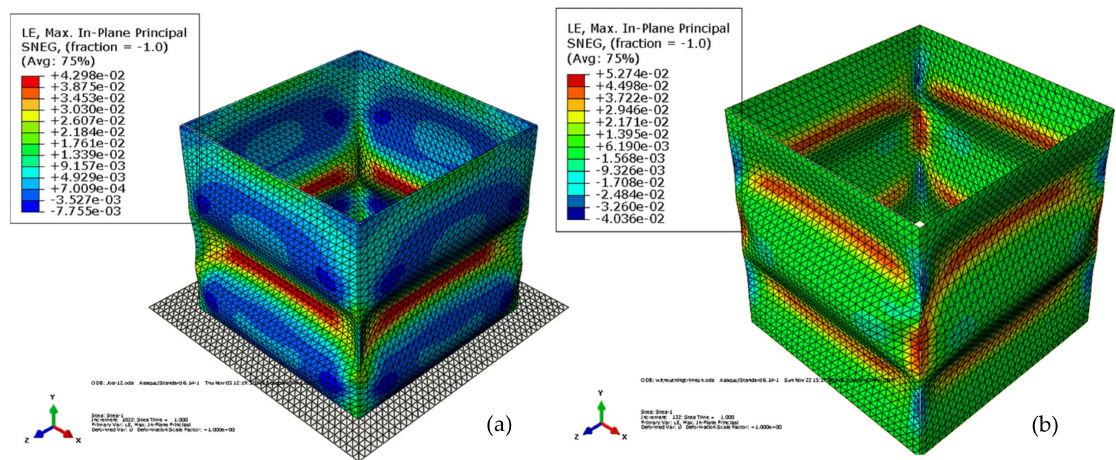
Figure 13. Total strain of the ( a ) creased and ( b ) uncreased cartons [155]. Reprinted with permission.